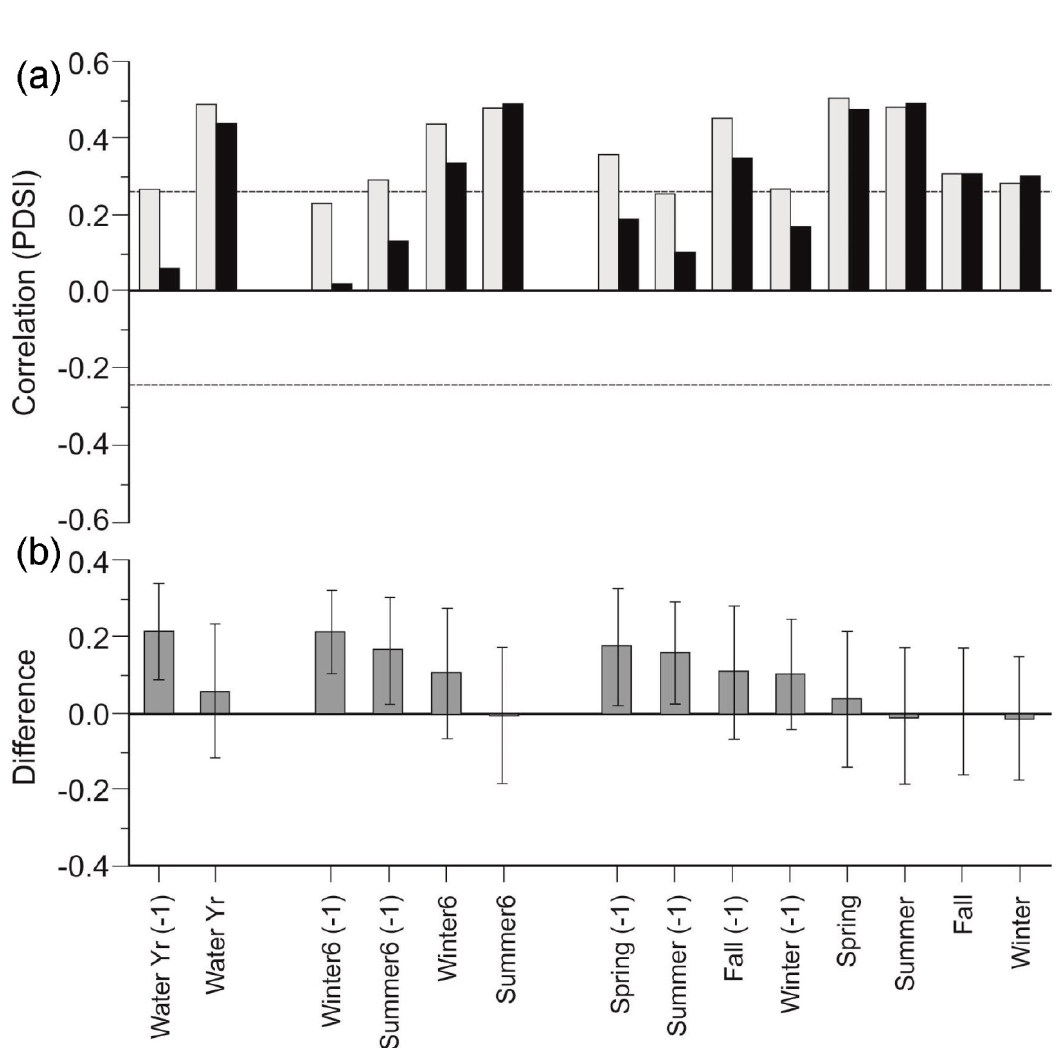
Figure 4. ( a ) Correlations between radial growth index of Oregon white oak growing at high density (light gray) and low density (solid) and seasonal values of the PDSI (see text for time windows). Significance levels, and confidence limits are indicated as in Figure 2. ( b ) Growth–climate response differences for the two chronologies. Positive values indicate that Oregon white oak growing at high density are more positively correlated to the PDSI than Oregon white oak growing at low density during that season. The error bars indicate the 95% confidence limit on the difference.